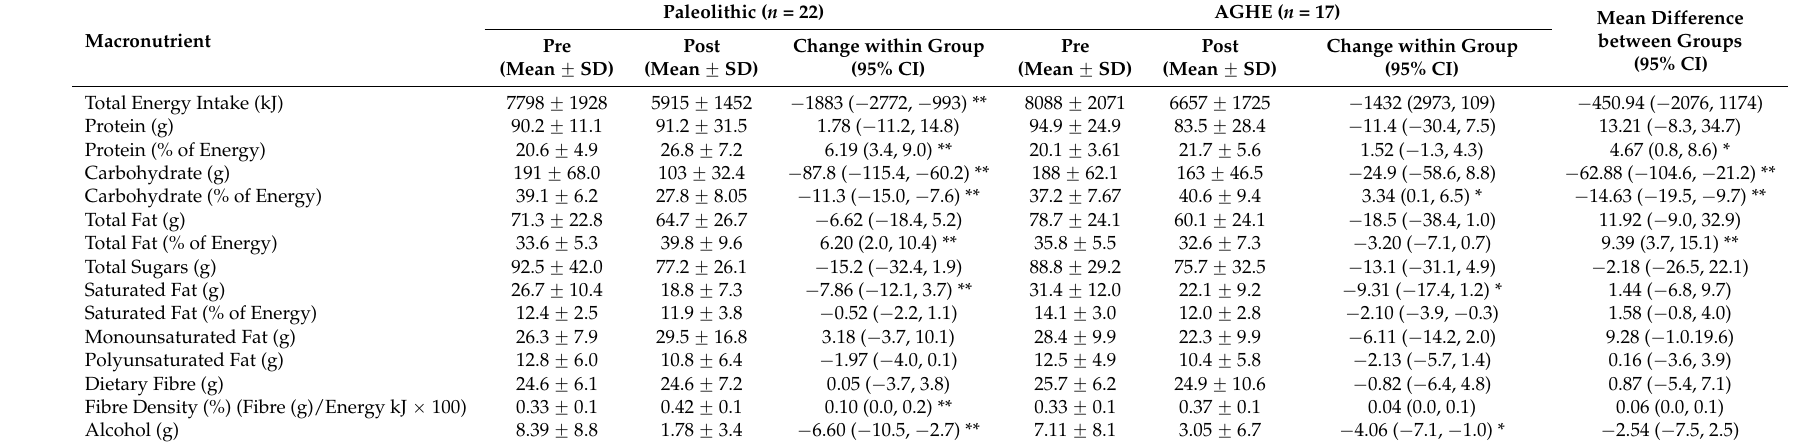
Table 3. Mean pre and post macronutrient intake, showing mean changes within and between groups 1